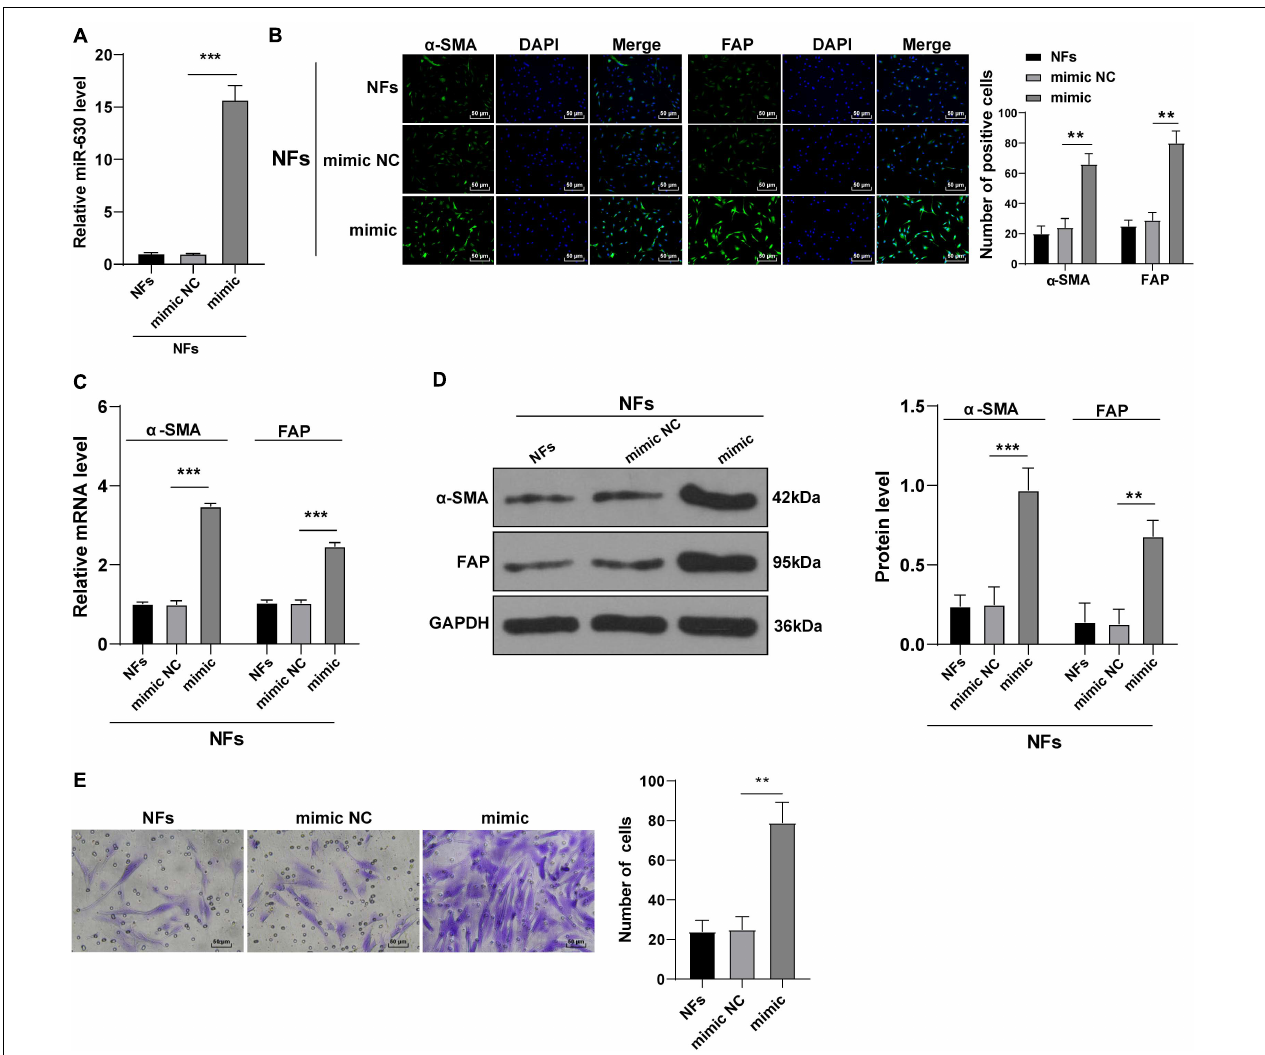
FIGURE 2 | Overexpression of miR-630 promoted transformation from NFs into CAFs. NFs were transfected with miR-630 mimic or its NC. (A) Transfection efficiency of miR-630 mimic was confirmed using RT-qPCR; (B) levels of CAFs marker proteins ( α -SMA and FAP) in NFs were detected using immunofluorescence; (C,D) levels of α -SMA and FAP were detected using RT-qPCR and Western blotting. (E) Migration of NFs in each group was detected using Transwell assays; the migrated cells were counted and representative images were displayed. The experiment was repeated three times independently. Data are presented as mean ± standard deviation and analyzed using one-way ANOVA, followed by Tukey’s multiple comparison test, ** p < 0.01, *** p <